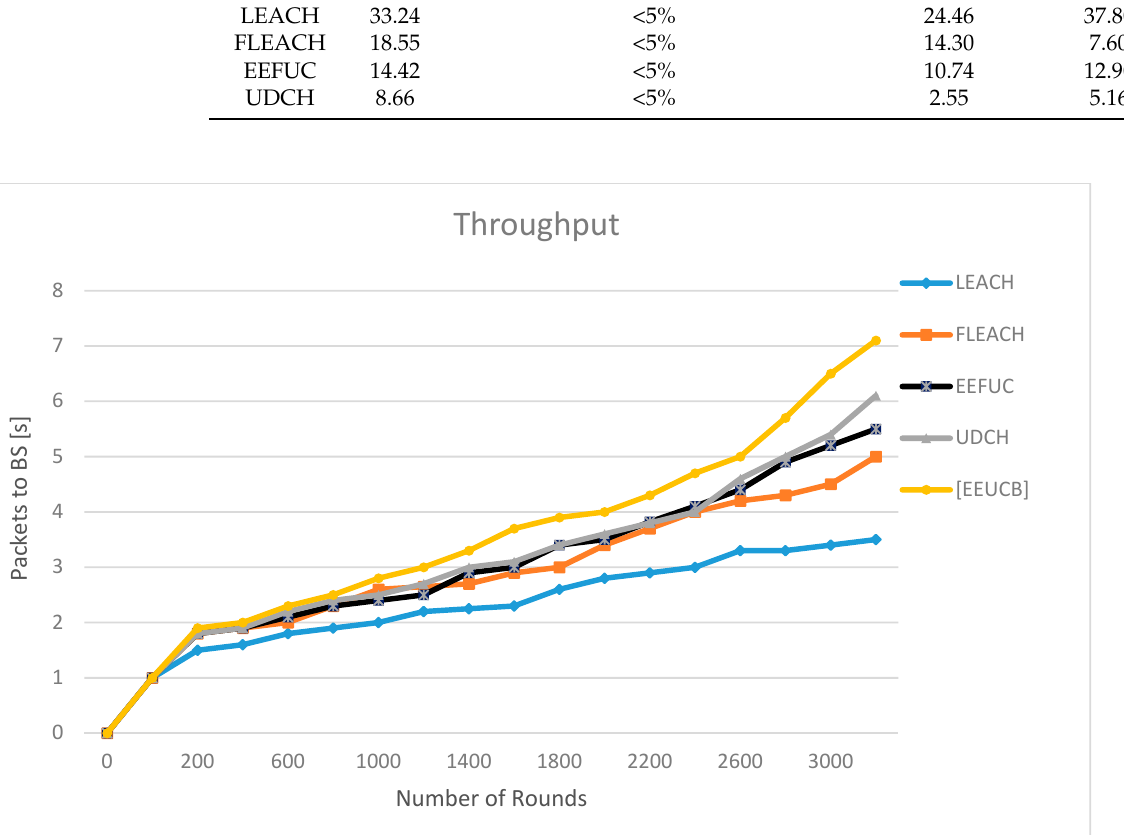
Figure 15. The throughput.